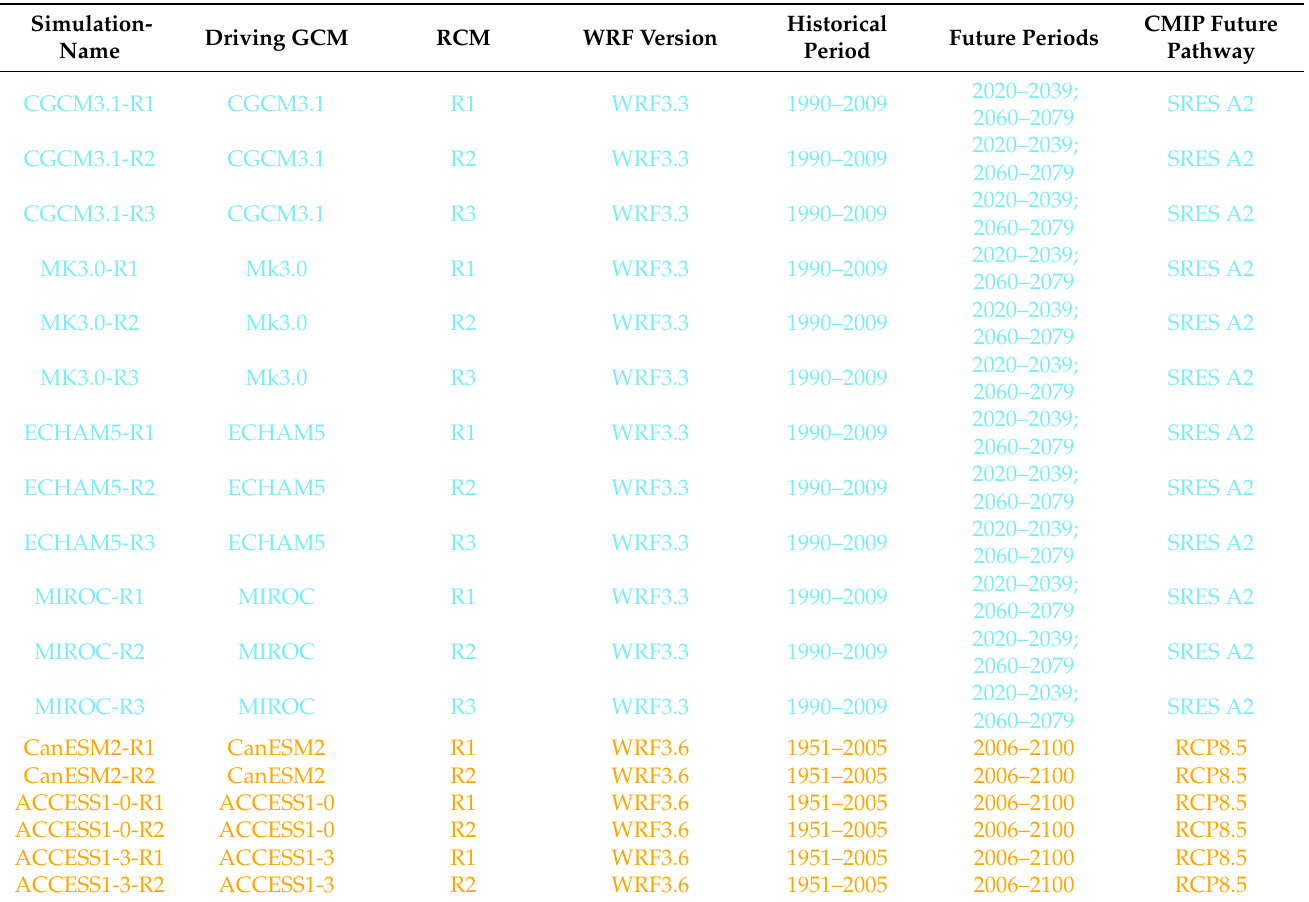
Table 1. NARCliM1.0 and NARCliM1.5 simulations used in this study. Here for clarity, blue and orange colours differentiate between N1.0 and N1.5